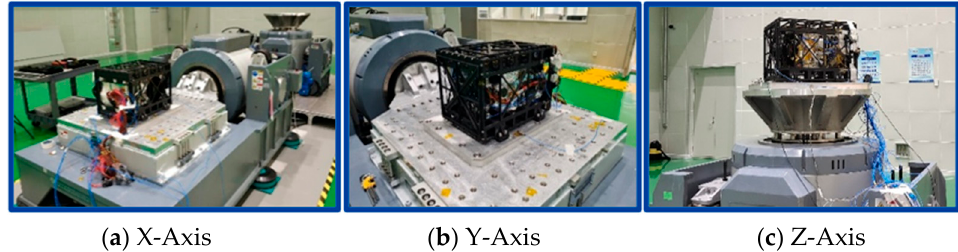
Figure 15. Vibration testing site.